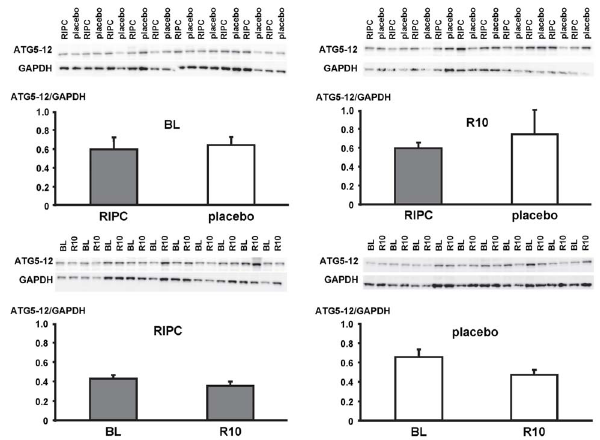
Figure 2. Expression of autophagy-related gene 5–12 complex (ATG5-12). Original Western blots of protein content of ATG5-12 in myocardial biopsies obtained at baseline (BL) before initiation of cardiopulmonary bypass and at 5–10 min reperfusion (R10) from patients undergoing remote ischemic preconditioning (RIPC) or not (placebo). Immunoreactivity of ATG5-12 was normalized to glyceralde- hyde 3-phosphate dehydrogenase (GAPDH). Ratios are presented in bar graphs.